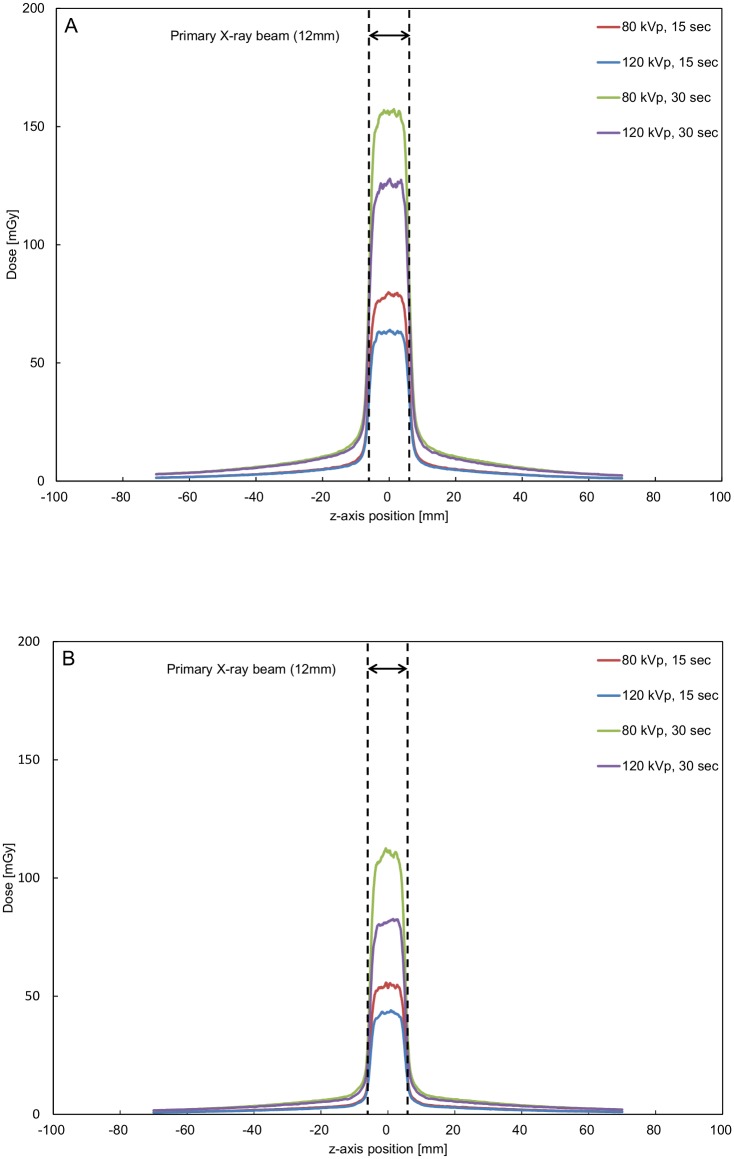
Dose profiles of CT fluoroscopy performed using optically stimulated luminescence dosimeters.A: Top. B: Lateral side. Each data point corresponds to the mean value of triplicate measurements.